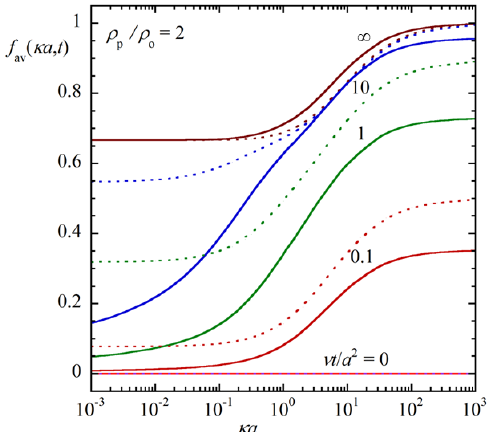
Figure 4. Time-dependent transient Henry function f av ( κ a , t ) of an arbitrarily oriented cylinder with radius a and mass density ρ p in an electrolyte solution of mass density ρ o , kinematic viscosity ν , and Debye–Hückel parameter κ plotted as a function of κ a for various values of scaled time ν t / a 2 at ρ p / ρ o = 2 (solid curves). The transient Henry function f sp ( κ a , t ) for a sphere [18] is also shown for comparison (dotted curves).